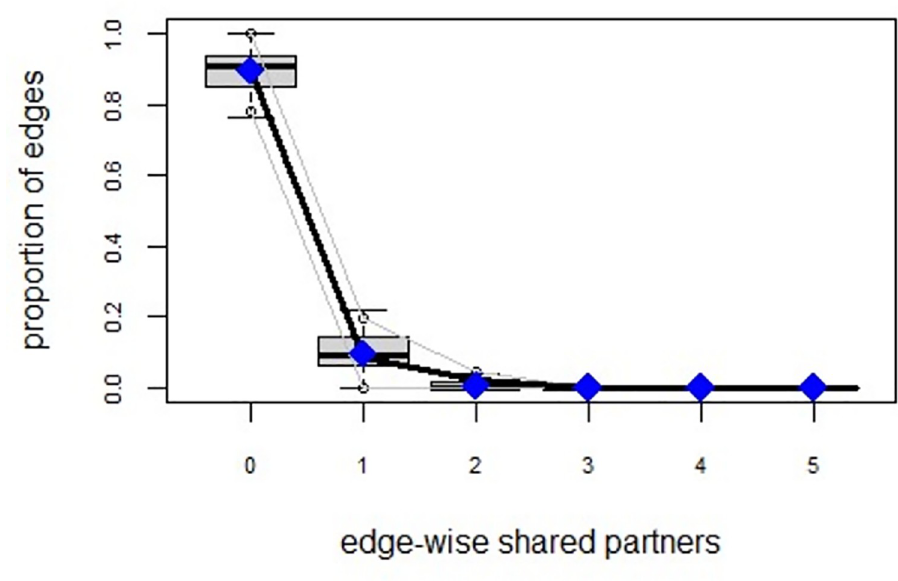
Fig 10. Multiplexity in the alpha community—goodness of fit [24] edge-wise shared